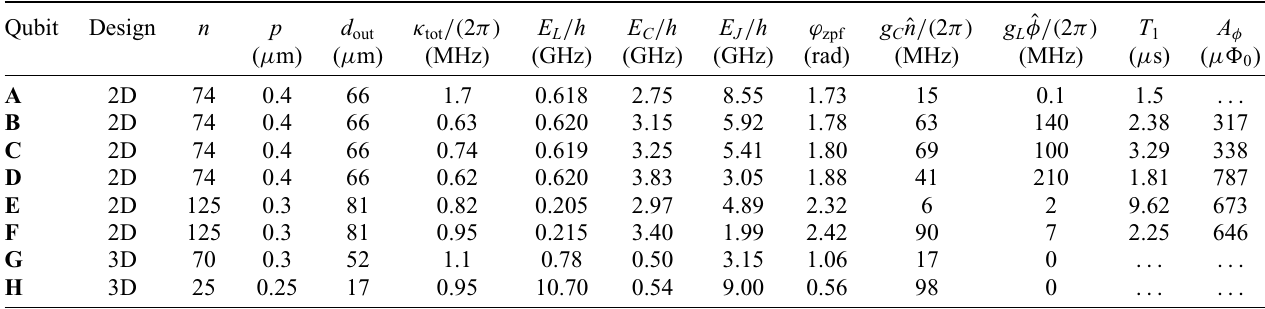
TABLE I. The qubit circuit parameters. The data include geometric properties such as the design type [two-dimensional (2D) or three-dimensional (3D)], the number of inductor turns n , the coil wire pitch p and outer diameter d out , and the total resonator line width / 2 π , as well as fitted qubit energies E κ tot L , E C , and E J extracted from the data shown in Fig. 5 in Appendix A, the calculated zero-point fluctuations of the phase ϕ zpf , the fitted coupling constants multiplied by the calculated matrix elements between states 0 and 1 at half flux, the measured values of T 1 also at half flux, and the fitted flux-noise amplitudes A φ